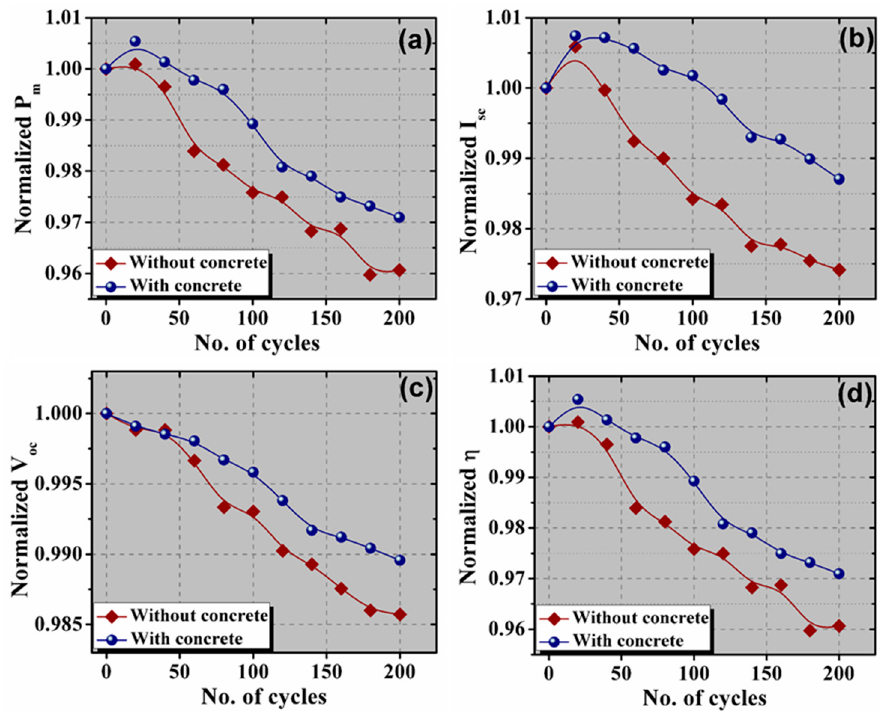
Figure 6. The variation of ( a ) maximum power, ( b ) short circuit current, ( c ) open-circuit voltage, and ( d ) conversion efficiency with thermal cycles.